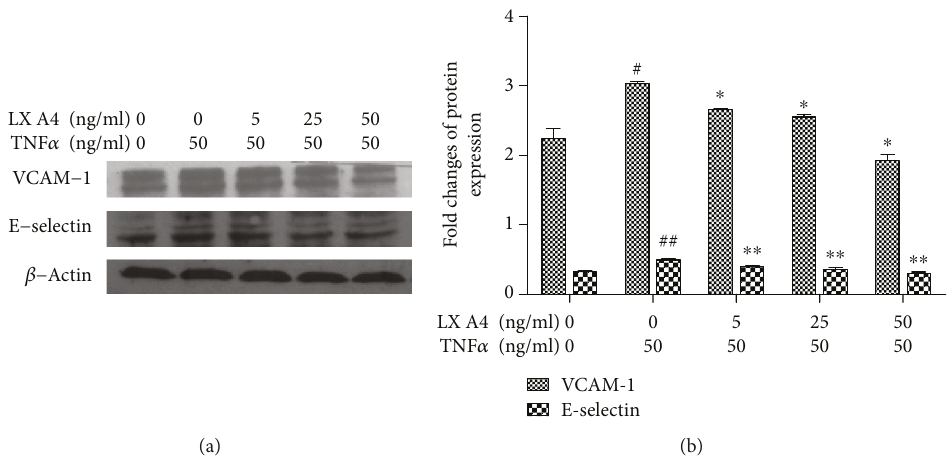
Figure 4: Downregulation of VCAM-1 and E-selectin expression in TNF- α -stimulated HPMECs by AT-Lipoxin A4. HPMECs were pretreated with AT-Lipoxin A4 (5, 25, and 50ng/mL) for 1 h followed by incubation with TNF- α (50 ng/mL) for 6 h. (a, b) Western blot assay shows expressions of VCAM and E-selectin in HPMECs. The data showed representatives of at least three independent experiments. # P < 0 01 compared with the control, ## P < 0 05 compared with the control, ∗ P < 0 05 compared with TNF- α in the absence of AT-Lipoxin A4, and ∗∗ P < 0 01 compared with TNF- α in the absence of AT-Lipoxin